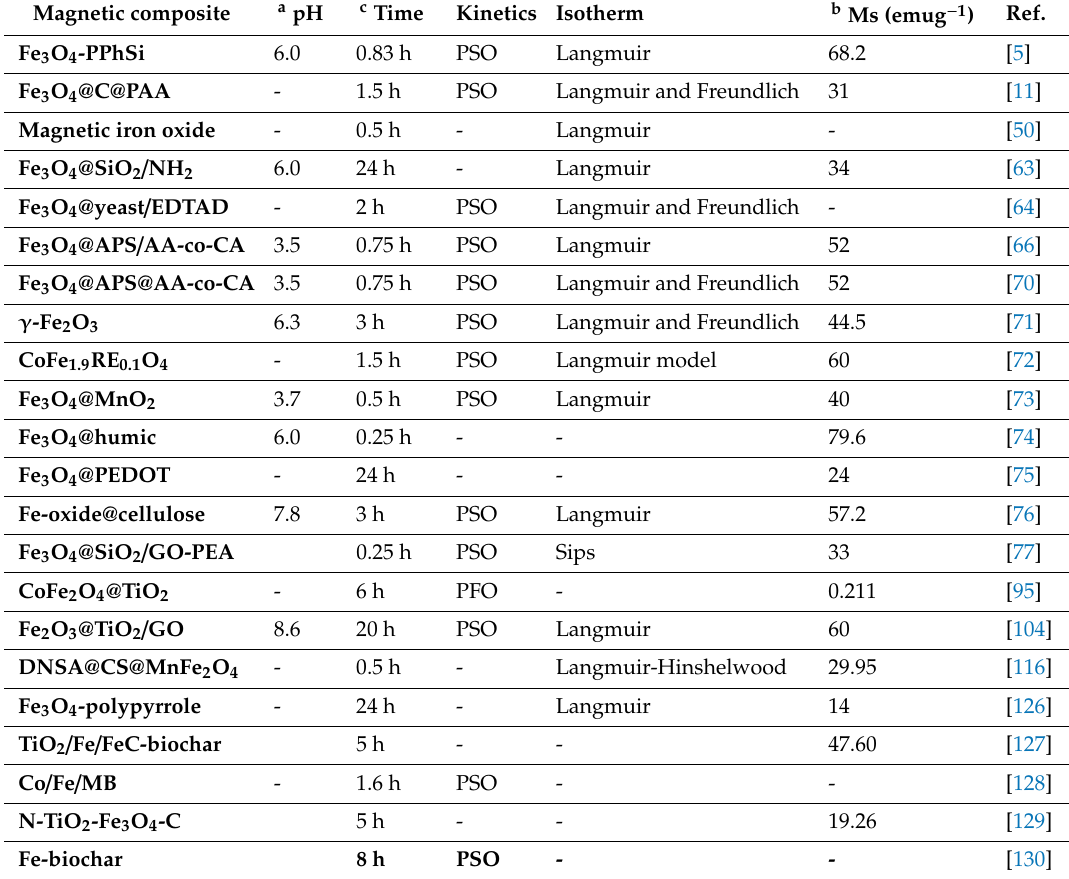
Table 4. Kinetics parameters of selected magnetic oxide nanocomposites for wastewater treatment. Magnetic